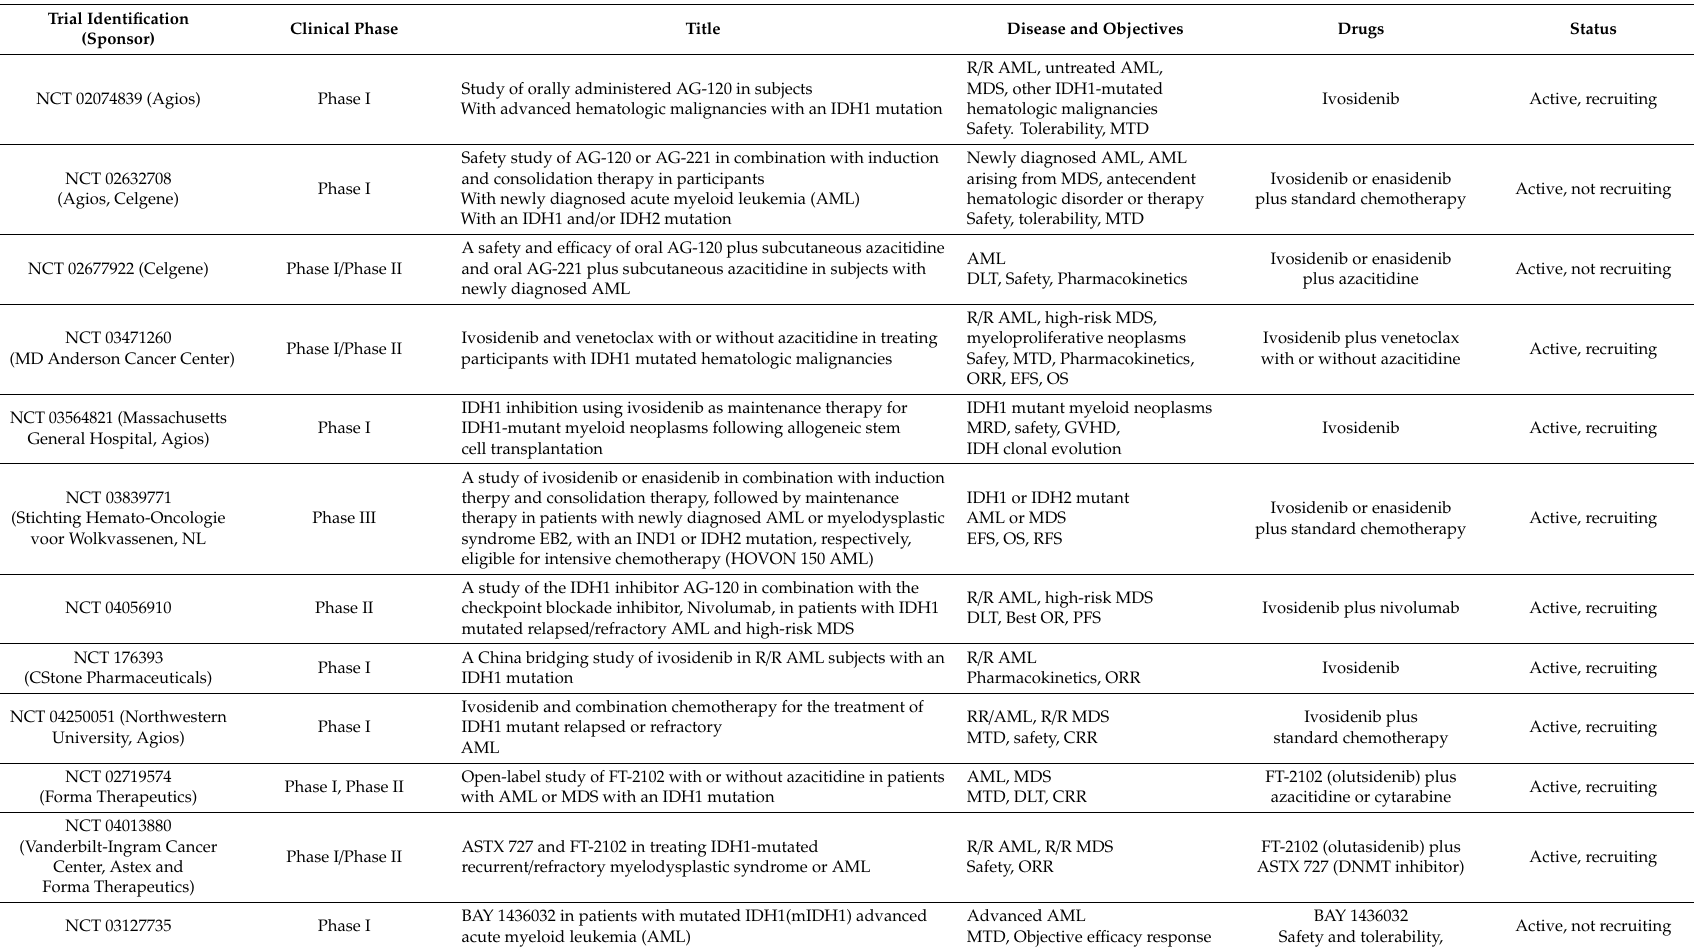
Table 3. Ongoing clinical trials of IDH1 inhibitors in AML and